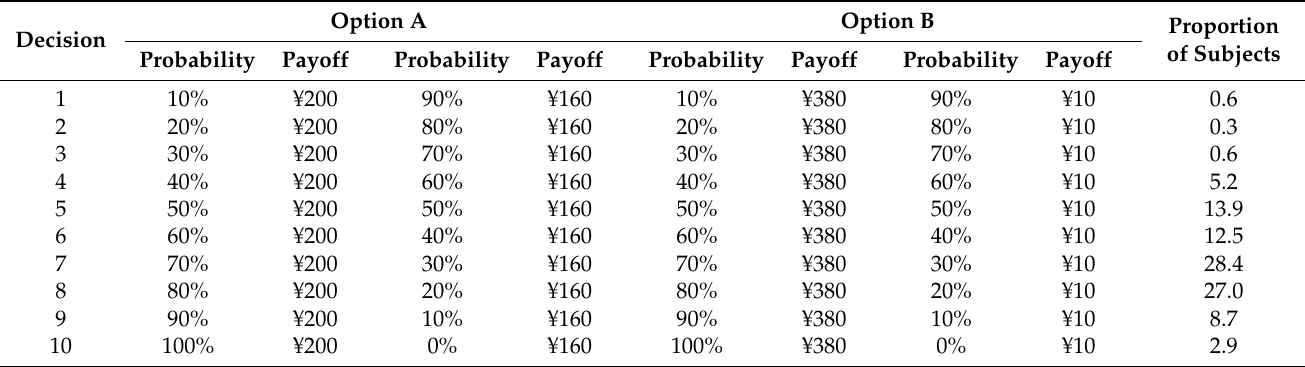
Table 1. Lottery choice experiment (Holt and Laury 2002